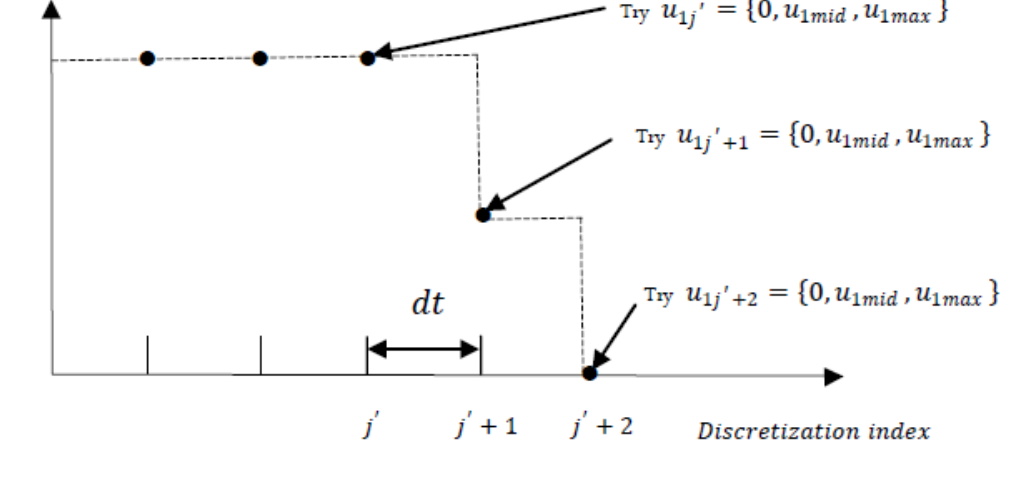
Figure 6. Vaccination strategy modification in stage III of algorithm.